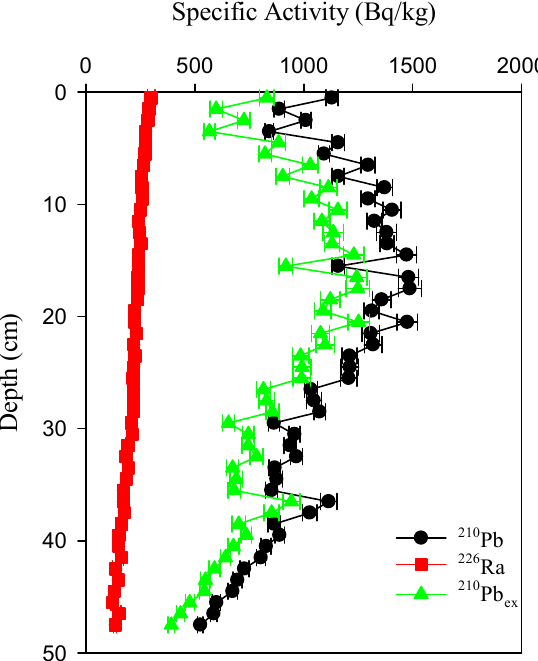
Figure 2. Profiles of 210 Pb, 226 Ra, and 210 Pb ex specific activity in the sediment